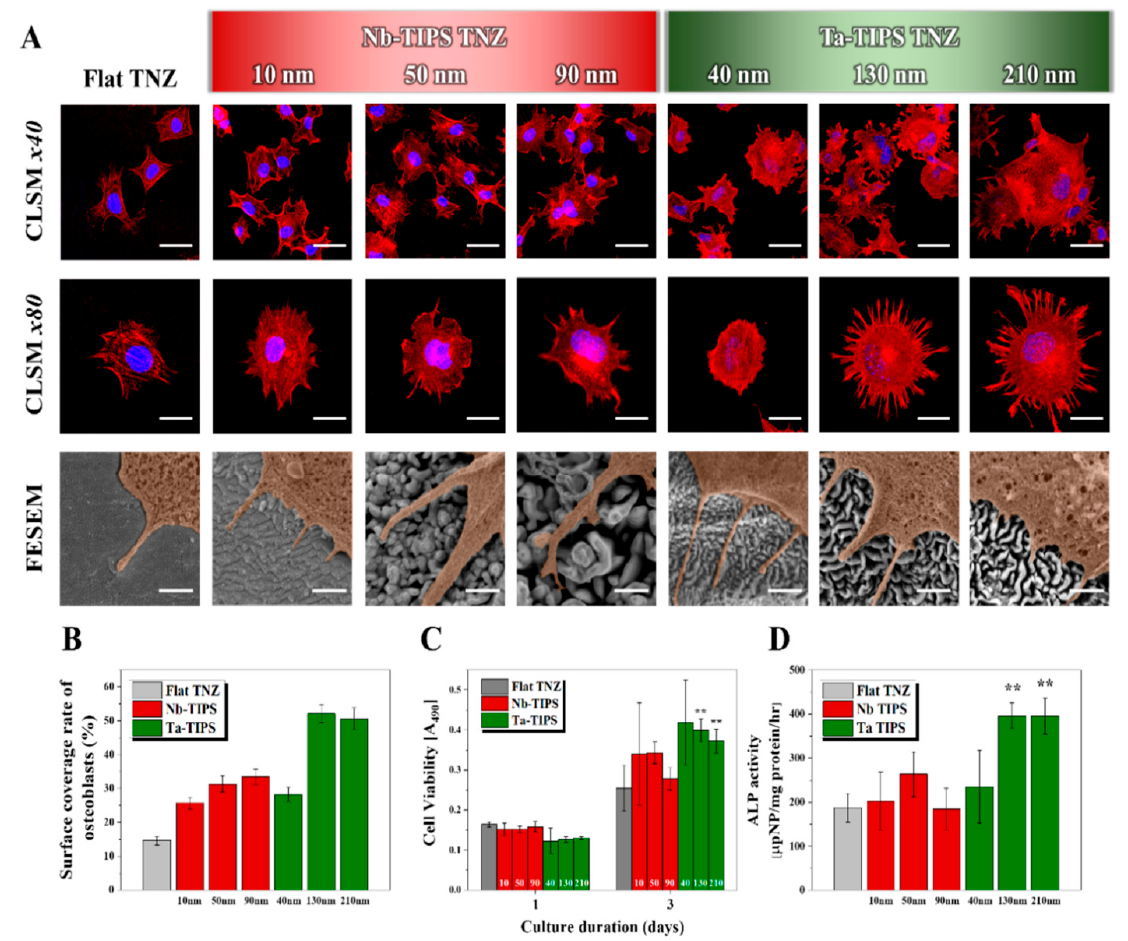
Figure 22. Experiments on Flat, Nb- (10, 50, and 90 nm), and Ta-TIPS (40, 130, and 210 nm)-coated TNZ were performed in vitro on osteoblast cells: ( A ) CLSM images of adherent cells on the substrates at low and high magnifications. ( B ) Quantitative measurement of the osteoblast cells’ interface covering ratio. Osteoblast cells’ differentiation (ALP activity) and cell proliferation ( C ) following 1, 3, 6, and 14 days, correspondingly (** p < 0.005) The white scale bars in the top, middle, and bottom lines, correspondingly, represent 50 nm, 25 nm, and 500 nm. ( D ) illustrates the cytocompatibility of the 130 and 210 nm groups was over two times higher than that of the control group. Reprinted with permission from [137]. Copyright 2021 MDPI. Distributed under Creative Commons Attribution- based license (CCBY